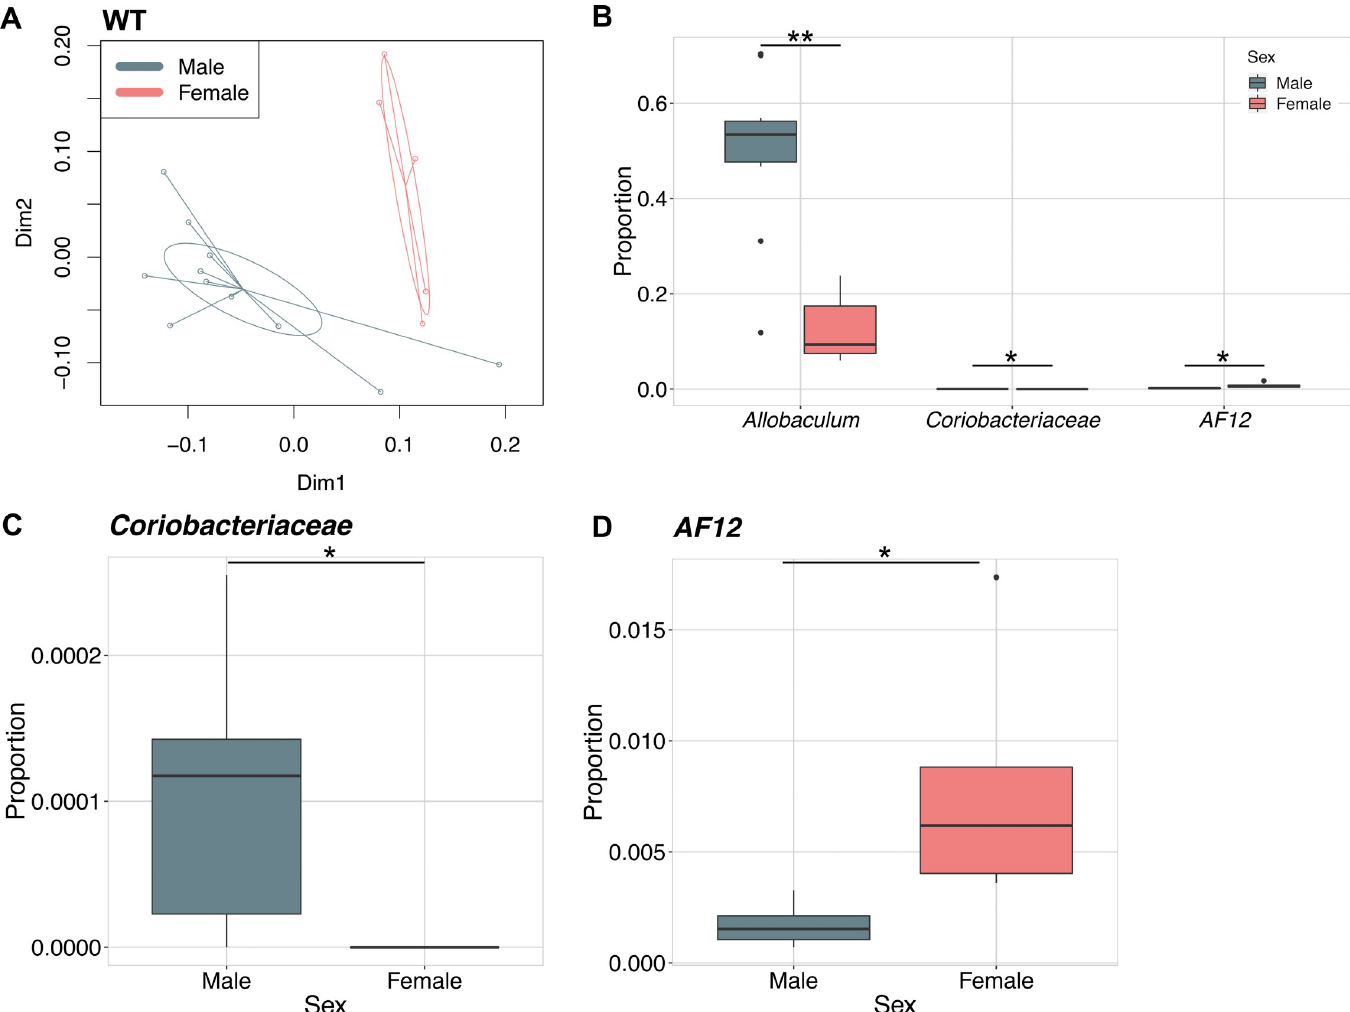
Fig 5. Microbial community structure differs between male and female Znt7 +/+ (WT) mice. (A) Principal coordinate analysis of the weighted UniFrac distance measures between gut microbial communities from male and female WT mice. (B) Boxplots of the relative abundances of bacterial taxa that were significantly differentially abundant between male and female mice as determined by DESeq2 analysis. (C and D) Boxplots of the relative abundance of (C) Coriobacteriaceae and (D) AF12 with the y-axes adjusted showed differences between sexes more clearly than in panel B. � , p < 0.05; �� , p < 0.01.